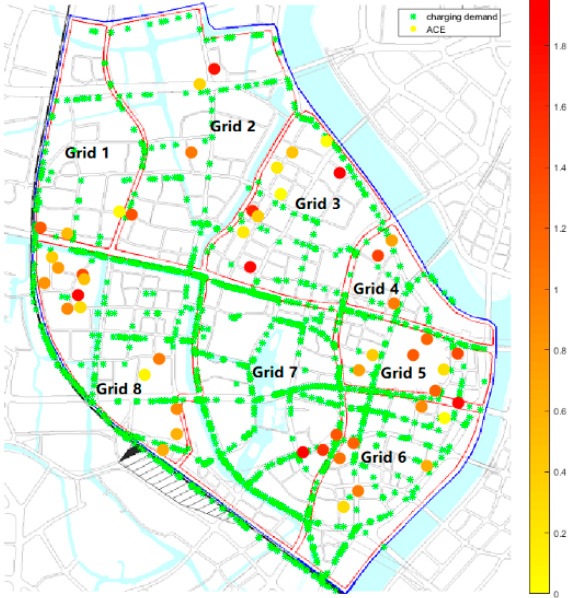
Figure 9. The spatial distribution of accommodation capability and charging demand for electric vehicles.